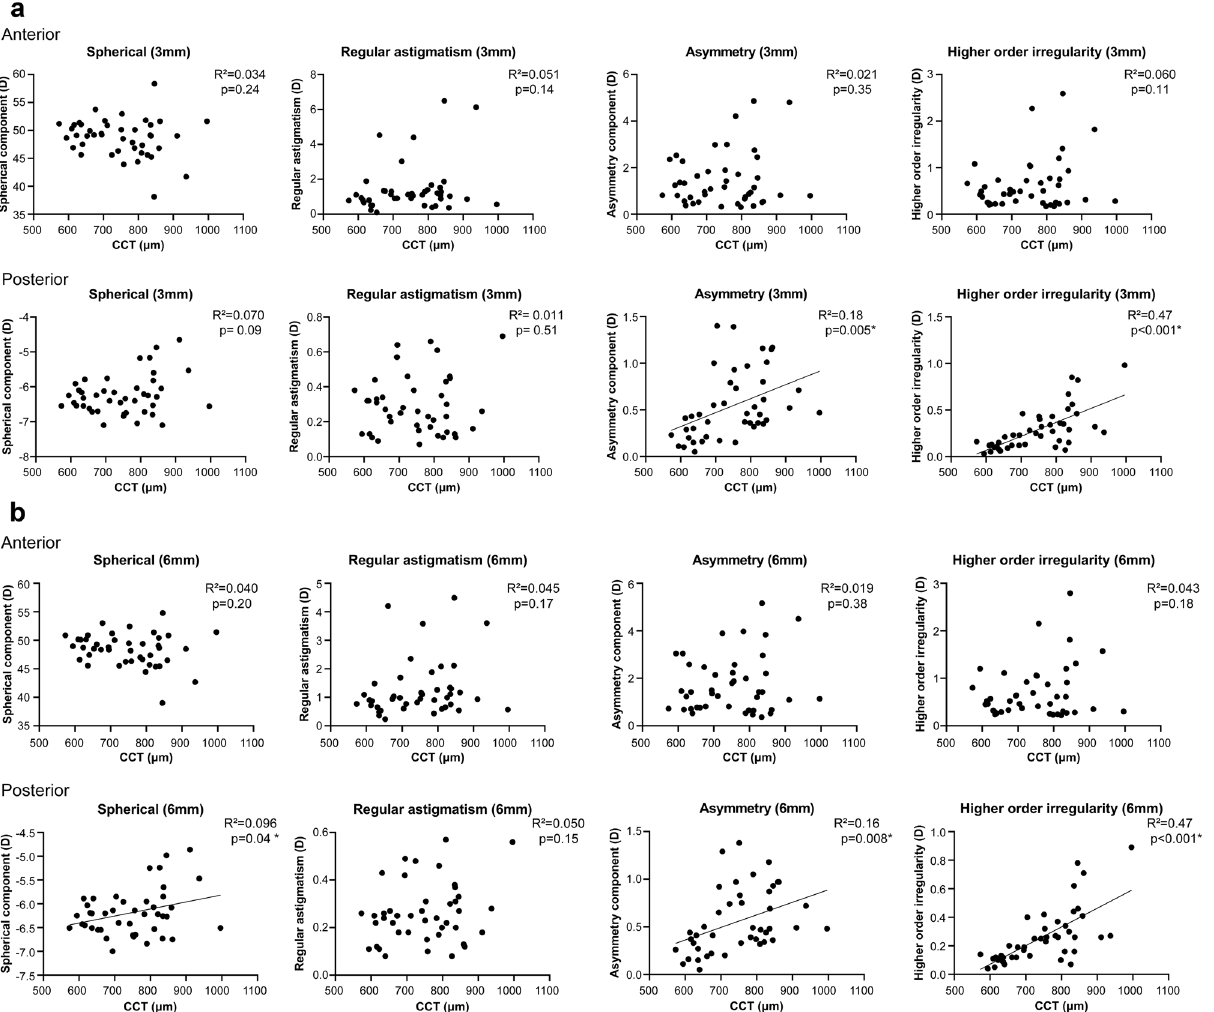
Figure 2. Linear regression between central corneal thickness (CCT) and each Fourier component in the anterior and posterior cornea within the central ( a ) 3 mm and ( b ) 6 mm zones. Significant correlations are seen for the posterior cornea between CCT and the spherical component within the central 6 mm zone (R 2 = 0.096, p = 0.04), asymmetry within the central 3 mm (R 2 = 0.18, p = 0.005), higher-order irregularity within the central 3 mm (R 2 = 0.47, p < 0.001), asymmetry within the central 6 mm zone (R 2 = 0.16, p = 0.008) and higher-order irregularity within the central 6 mm zone (R 2 = 0.47, p < 0.001). Regression lines are drawn for graphs